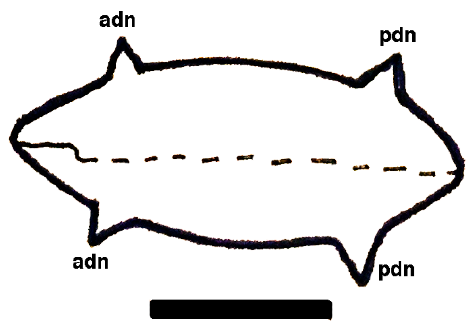
Figure 29. Quadricona madonnae . Dorsal view of conjoined shields; anterior to left. Scale bar 500 microns. Abbreviations: adn , anterodorsal node; pdn , posterodorsal node. Image Credit: Mark McMenamin.